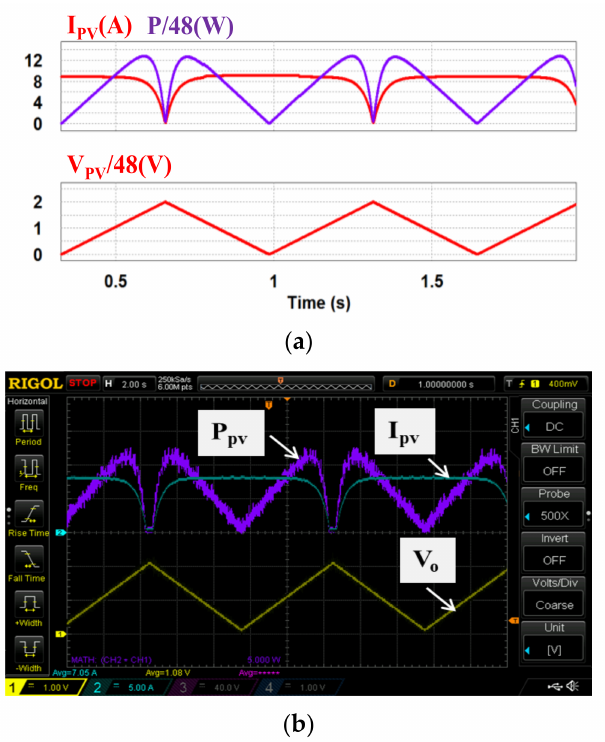
Figure 13. Experimental results of the proposed PV emulator under S = 1000 & 1000: ( a ) simulated power and current outputs and PV voltage; ( b ) implemented power and current outputs and PV